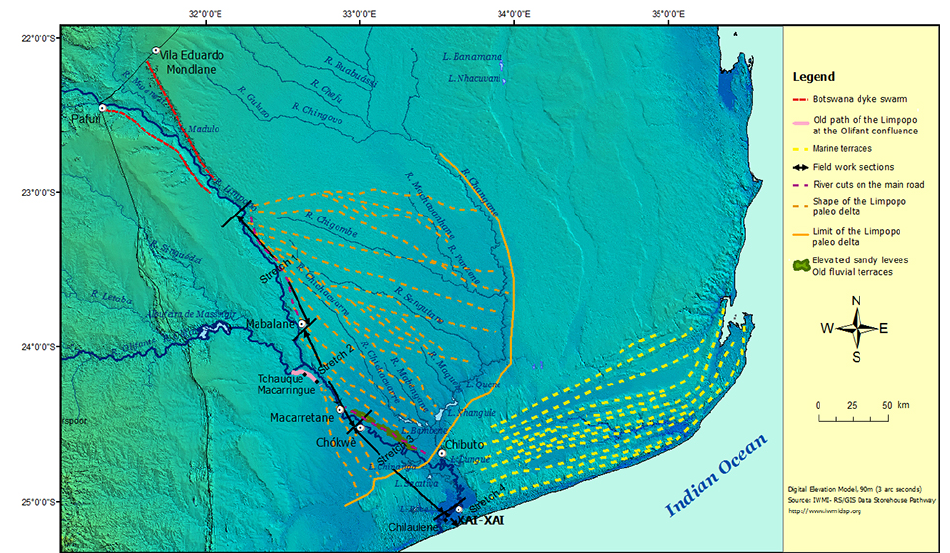
Figure 12. Main geomorphological features of the lower Limpopo